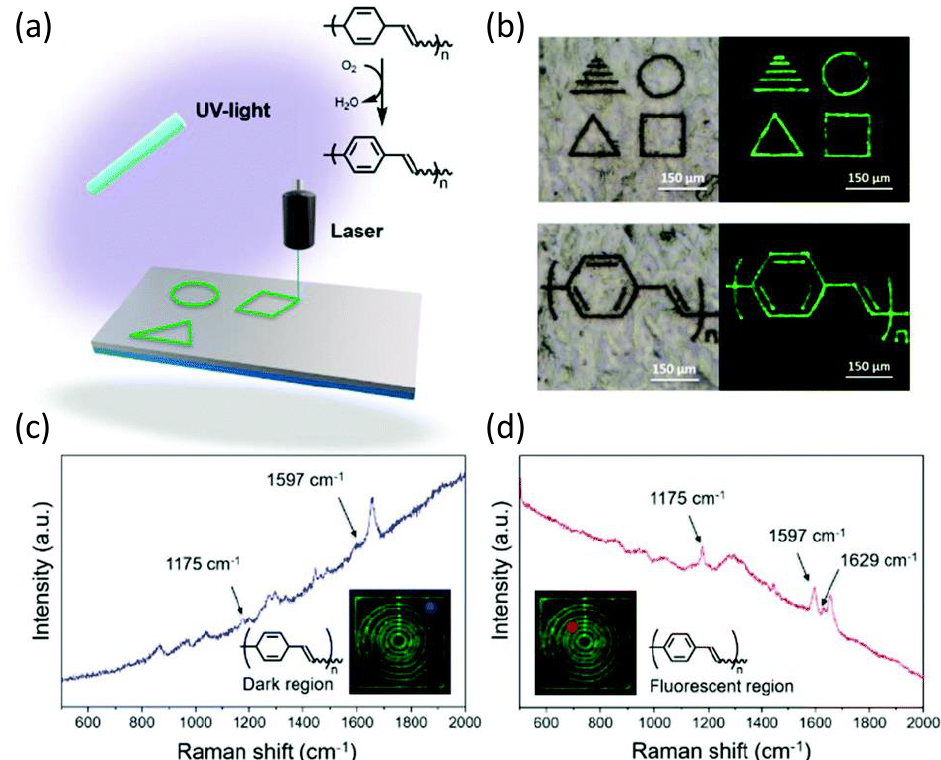
Figure 13. ( a ) Laser-induced oxidation of poly(barrelene) to polyphenylene vinylene (PPV). ( b ) Examples of patterns that were written. Photographs were taken under visible light (left) and UV light (λex = 488 nm; right). ( c , d ) Raman spectra were recorded for the areas indicated in blue or red (see insets) of a film subjected to DLW. The films were prepared by drop-casting a solution of poly(barrelene-co-norbornene) (200 mg) in CH 2 Cl 2 (4 mL) into a PTFE mold. Reproduced from reference [101] with permission from the Royal Society of Chemistry (Licensed under CC-BY 3.0).